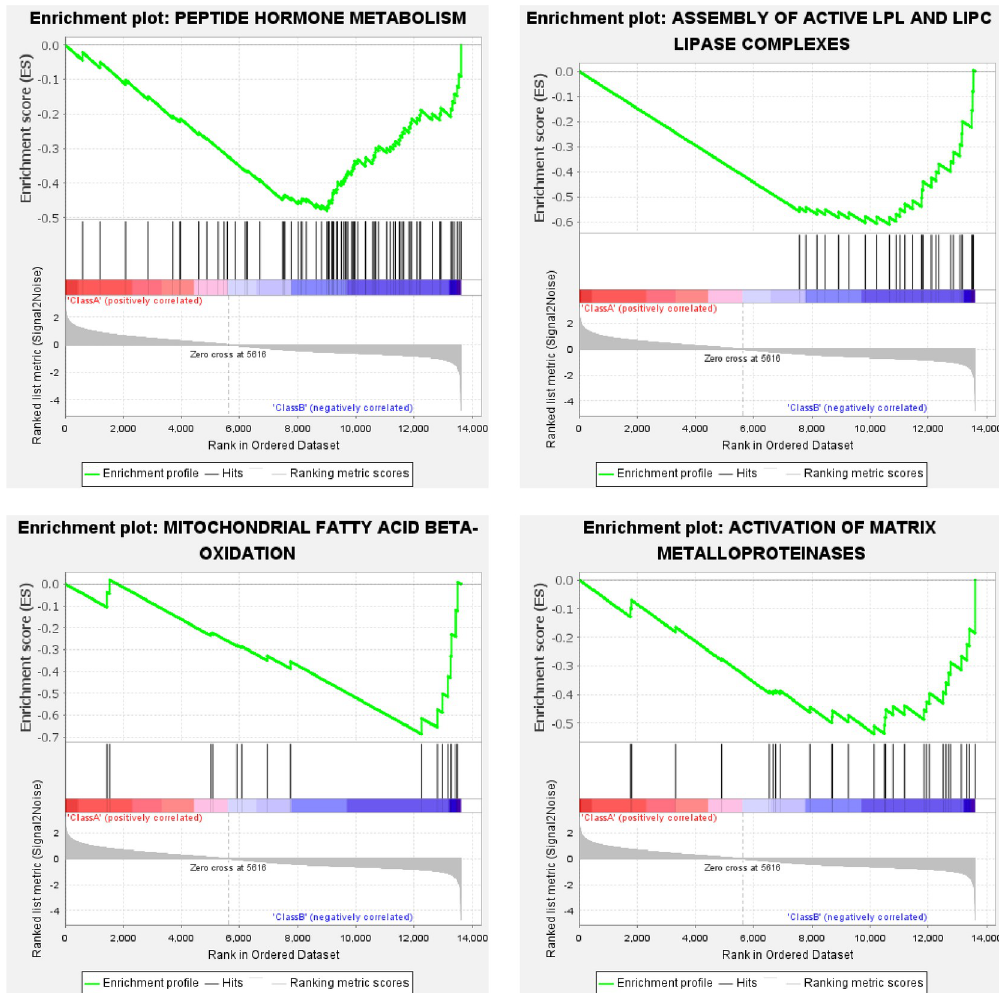
Fig 3. Representative Reactome enrichment plots of the REPO group. For each plot, the upper part shows the enrichment score; while the lower part shows ranked list metric of the gene set. The middle part shows the ranked gene list, with red meaning upregulation, blue for downregulation, and black vertical line for the genes of the